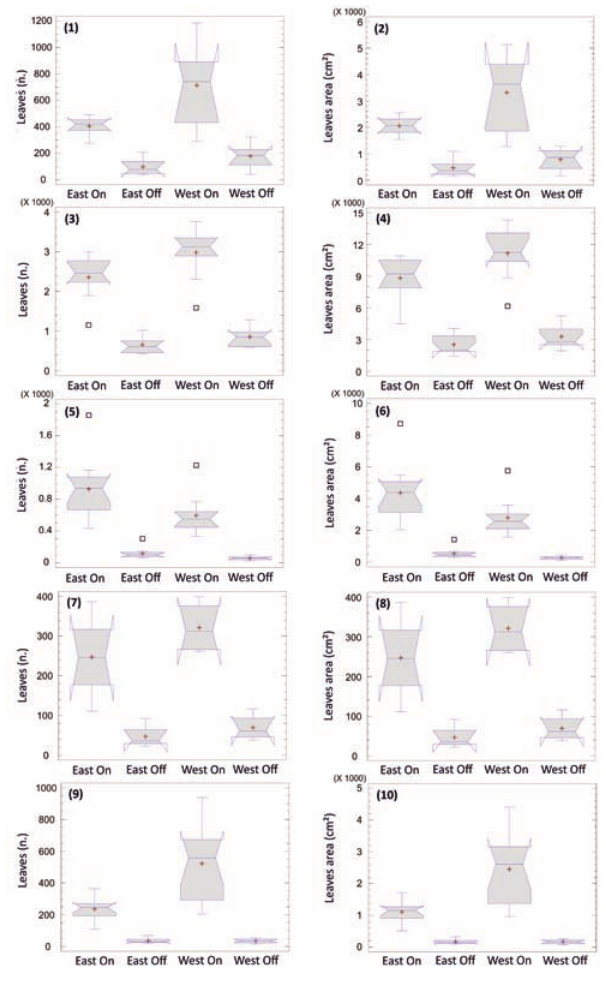
Fig. 3 - Box-and-Whisker plots related to the leaves number and area as influenced by the flow (On/Off) and side (Est/West). 1-2: ‘Arbequina’, 2014; 3-4: ‘Tosca’, 2014; 5- 6: ‘Arbequina’, 2015; 7-8: ‘Sikitita’, 2015, 9-10: ‘Arbequina’, 2018. Median notches, and mean (+) ± S.D. Notches added to the plot show the estimation error associated with each median; if they do not overlap, highlight which medians are significantly different from which others at 95% confidence level. Mean markers (+) indicate the location of samples mean. Outliers are indicated ( (cid:0) ) if